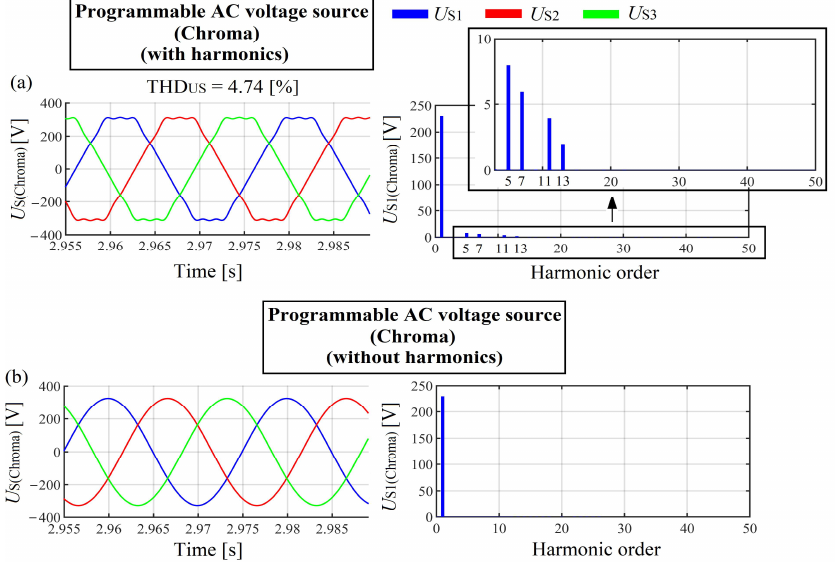
Figure 22. Voltage waveforms and spectrum measured at the programmable AC voltage source terminals when no load and filter were connected: ( a ) voltage with harmonics; ( b ) voltage without